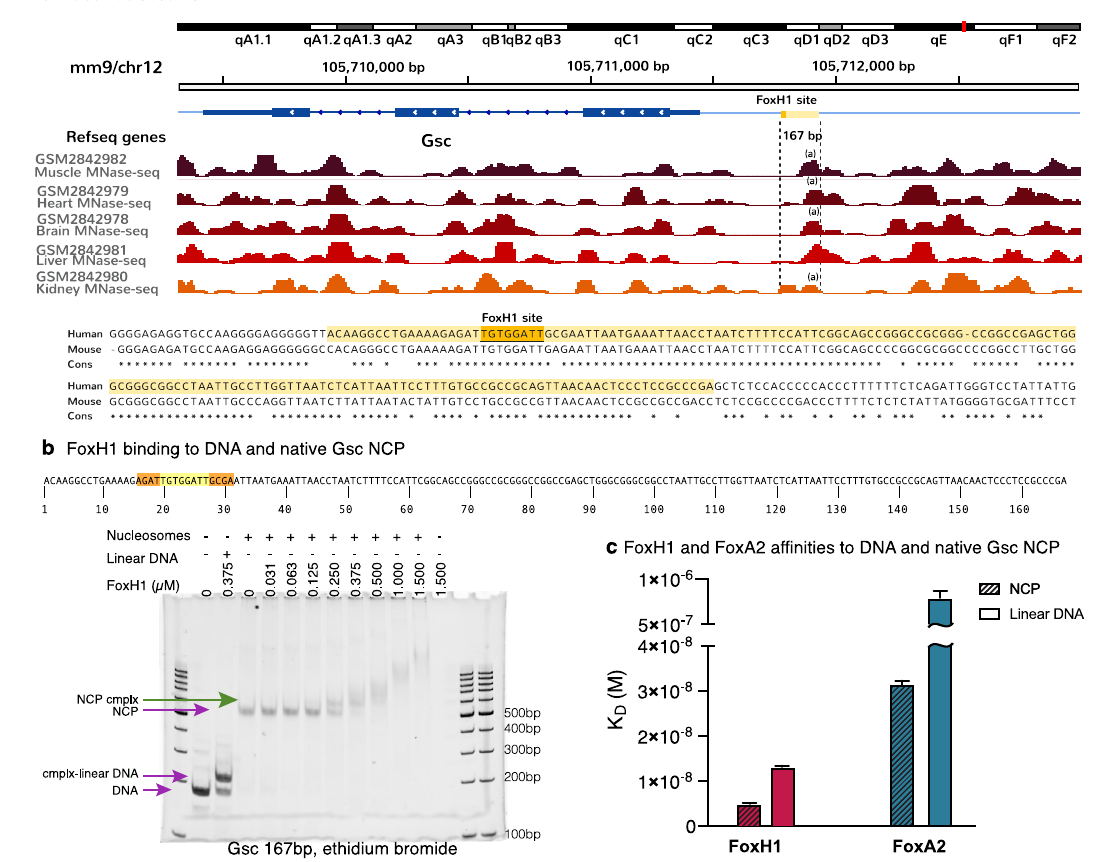
Fig. 7 | interactions between the FoxH1 FH domain and a native Gsc promoter nucleosome. a Gsc boundaries (dashed lines) were selected based on the MNase seq information described in GSM2842982 (mouse). The boundaries are more similar in muscle, heart, brain and liver than in kidney datasets, with differences perhaps indicating NCP dynamics in the different conditions.Inthis work, weused the Gsc sequence corresponding to the ( a ) site. The Gsc human NCP sequence (in light yellow) contains the FoxH1 site (highlighted in orange). Both human and